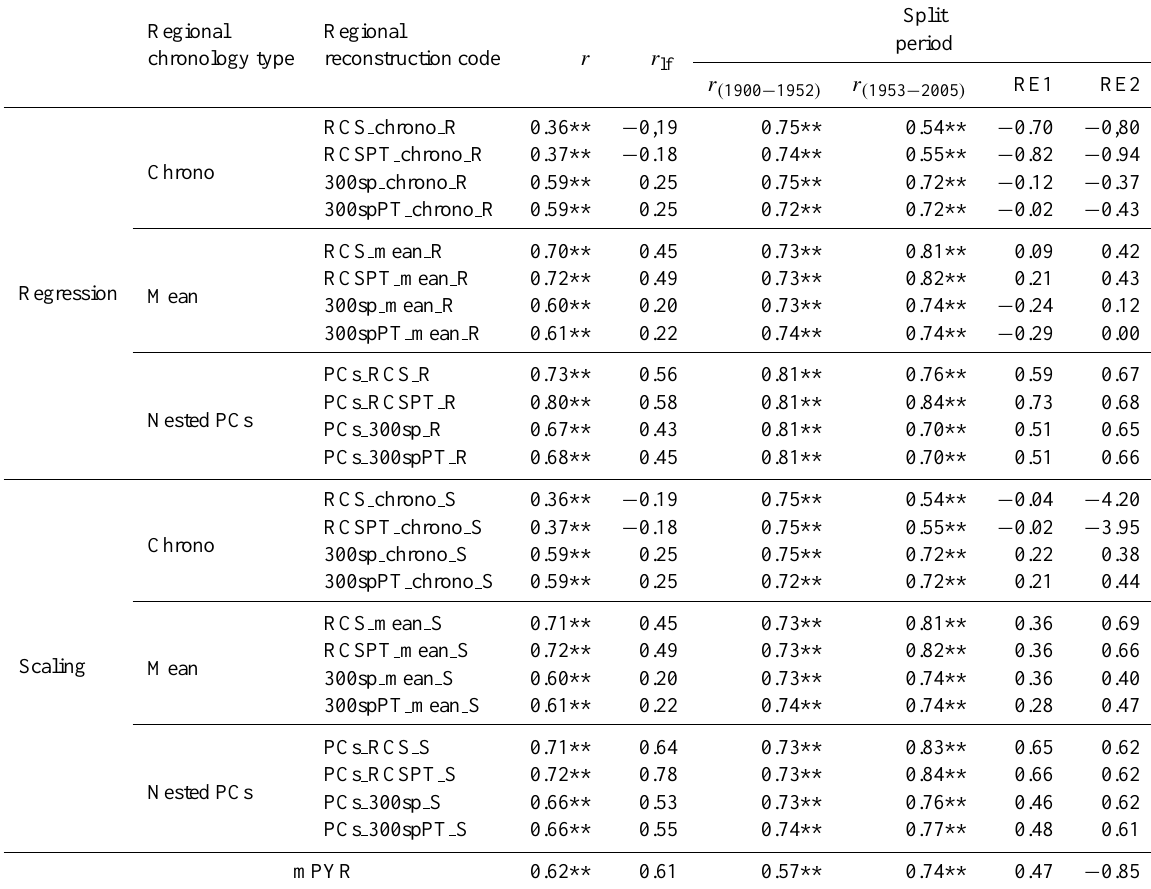
Table 1. Statistics of the calibration verification for the 24 regional chronologies developed. r indicates correlation between instrumental and predicted May-to-September temperatures ( T MJJAS ) : for the entire period 1900–2005AD ( r ); for the entire period in series low-pass filtered with a 20yr moving average ( r lf ) and for the correlations for the two periods of the calibrations ( r 1900 − 1952 and r 1953 − 2005 , respectively). RE: reduction of error for the two split periods. (**) indicates significant correlation at 99%